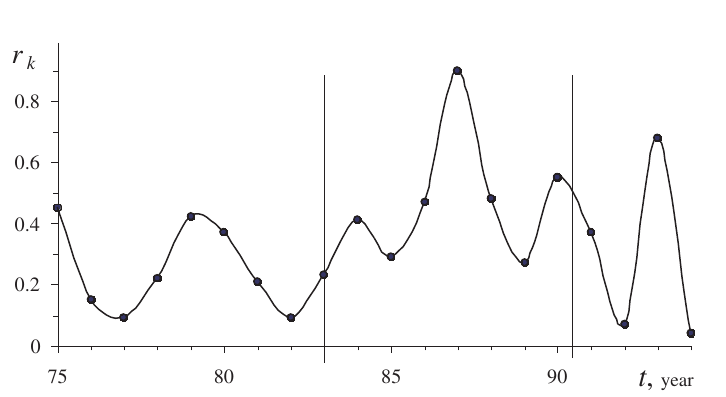
Fig. 6. Spatial-temporal correlation of density of earthquakes of the North Tien Shan and adjacent areas as function of time. The vertical axis indicates the values of a correlation function r k ; the horizontal axis indicates time in years. The vertical points are time of beginning and termination of a series of MHD-generator start-ups on the Bishkek